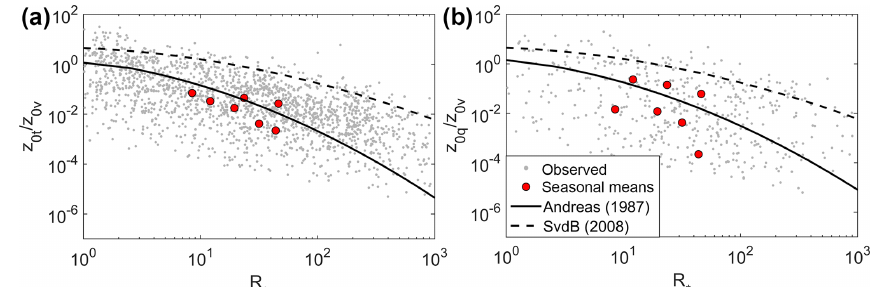
Figure 7. Performance of the surface renewal models of Andreas (1987) and Smeets and van den Broeke (2008) for estimating the ratio of (a) z 0t and (b) z 0q to z 0v . The filtered 30min (grey) and seasonal mean (red) ratios of the EC-derived roughness lengths and R ∗ values are shown for all seasons and EC sensors.